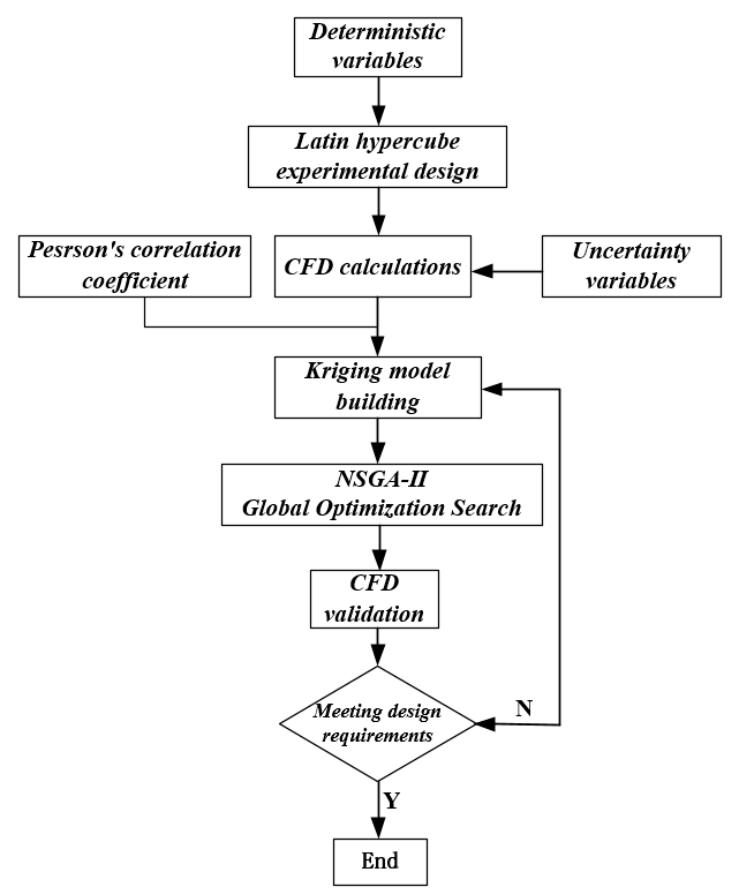
Figure 11. An optimization flow chart.